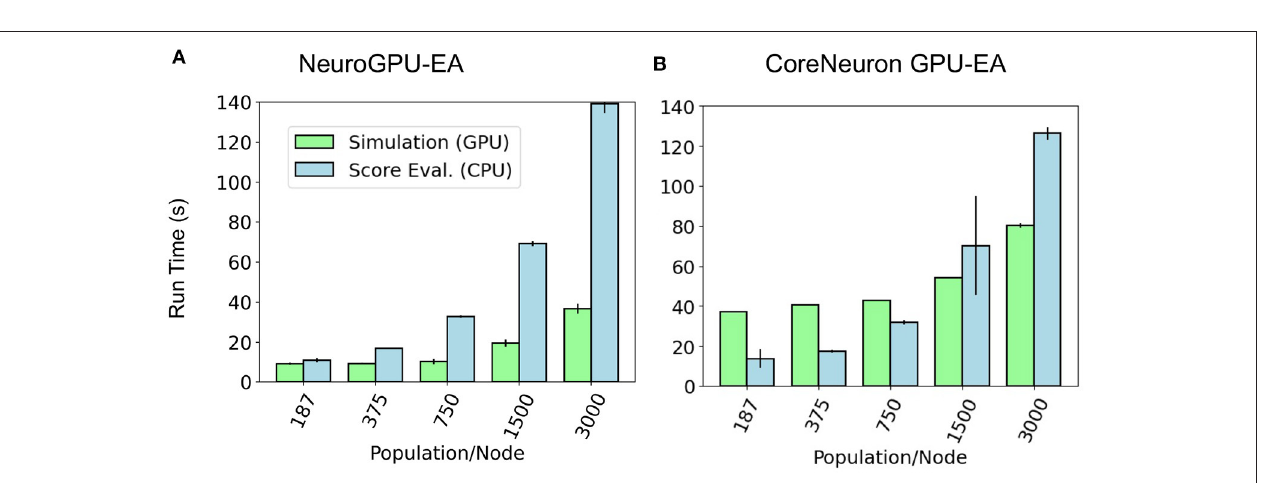
FIGURE 4 | GPU bottleneck shifts to CPU as population per node increases: at large population sizes the CPU operation for score functions is the bottleneck—denoted by relatively taller bars for CPU Eval. At smaller population sizes in (B) the GPU simulation is the bottleneck for CoreNeuron-EA —denoted by relatively taller bars for simulation. CPU and GPU time are balanced at small population sizes for NeuroGPU-EA in (A)